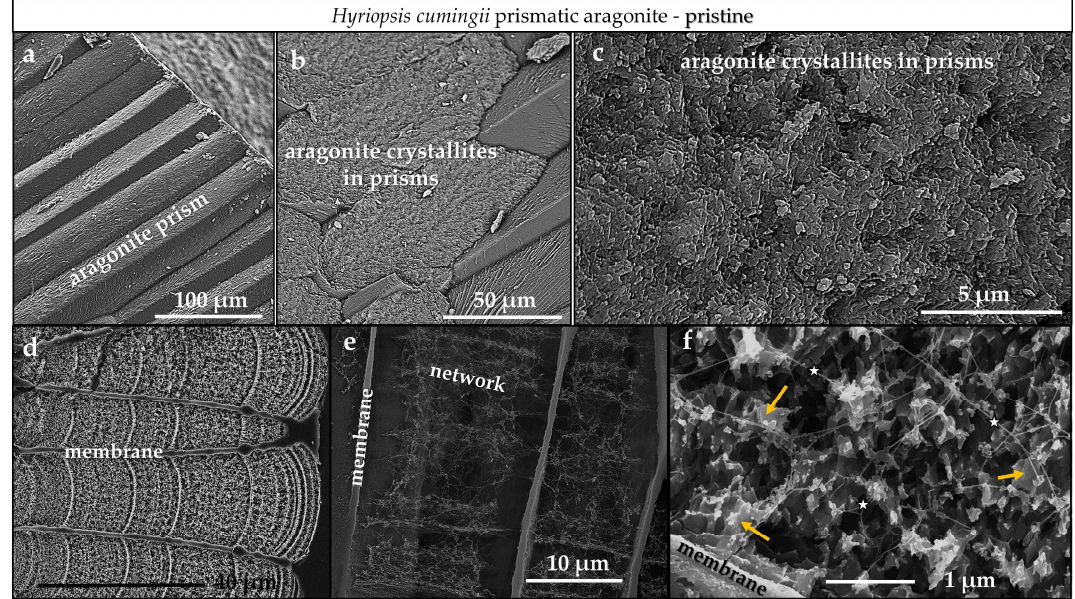
Figure A10. FE-SEM images depicting microscale features of pristine Hyriopsis cumingii prismatic aragonite. ( a ) Aragonitic prisms comprise the outer shell layer adjacent to seawater, with all prisms being encased by organic membranes ( d , e ). Each prism consists of aragonite crystallites ( b , c , f ), embedded in an irregular network of thin biopolymer fibrils ( e , f ).